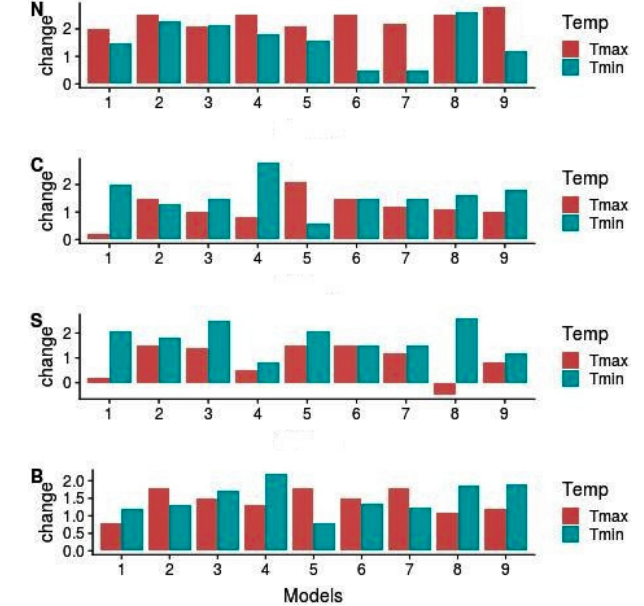
Figure 2. Maximum and minimum temperature changes ( ◦ C) between far future (2071–2100) and historical period (1971– 2000) during May to September for models: (1) CNRM-CM5, (2) MIROC5, (3) EC-EARTH, (4) IPSL-CMA5-MR, (5) MPI-ESM- LR, (6) GFDL-ESM2M, (7) NorESM1-M, (8) CanESM2 and (9) Models-Mean (ensemble mean of Model) in the North (N), Center (C), South (S) and over mono basin (B).